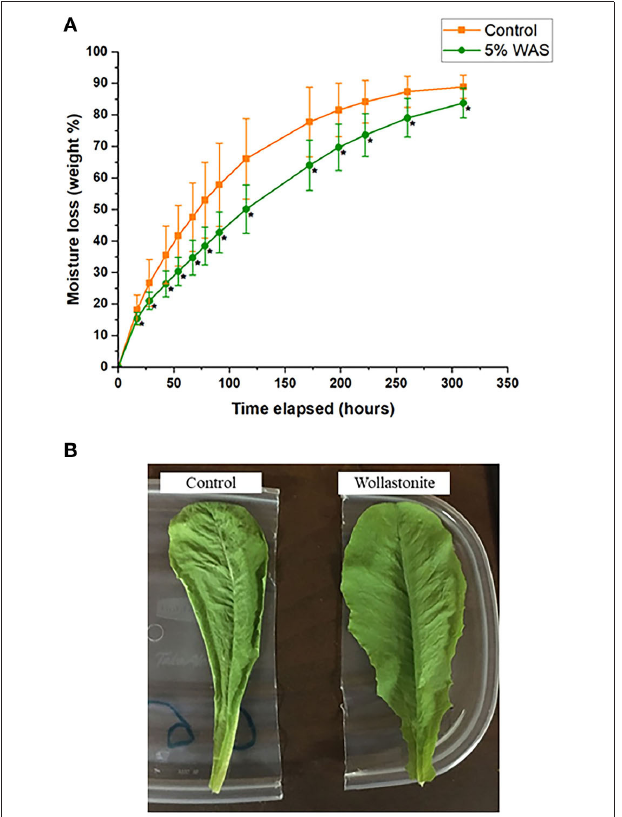
FIGURE 3 | (A) Lettuce wilt experiment showing moisture loss over time for lettuce grown with and without wollastonite skarn (*points with statistical significance using paired t -test; p < 0.05), (B) Lettuce grown with and without wollastonite skarn shown after 115h during the wilt test experiment.